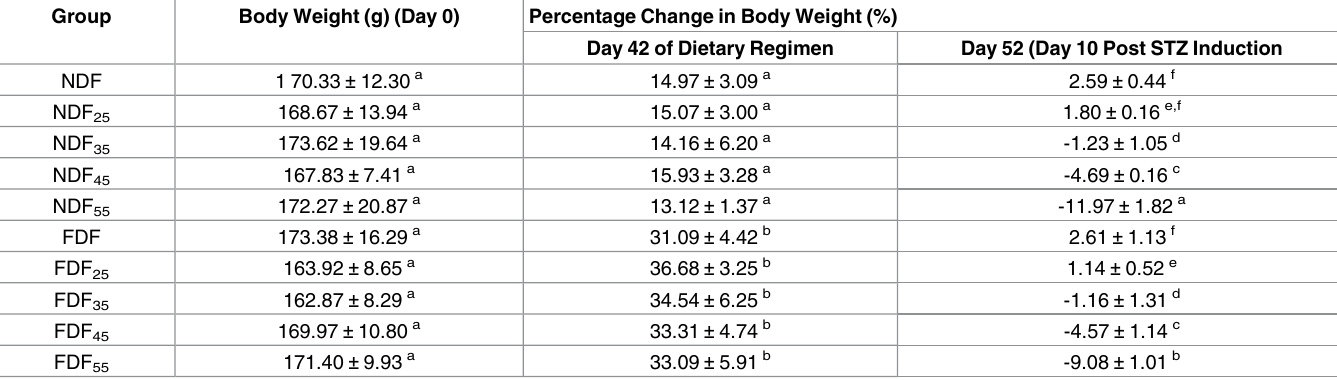
Table 1. Percentage Change in Body Weight of Rats after Dietary Regimen and STZ Induction. Group Body Weight (g) (Day 0) Percentage Change in Body Weight (%) Day 42 of Dietary Regimen Day 52 (Day 10 Post STZ Induction NDF 1 70.33 ± 12.30 a 14.97 ± 3.09 a 2.59 ± 0.44 f NDF 25 168.67 ± 13.94 a 15.07 ± 3.00 a 1.80 ± 0.16 e,f NDF 35 173.62 ± 19.64 a 14.16 ± 6.20 a -1.23 ± 1.05 d NDF 45 167.83 ± 7.41 a 15.93 ± 3.28 a -4.69 ± 0.16 c NDF 55 172.27 ± 20.87 a 13.12 ± 1.37 a -11.97 ± 1.82 a FDF 173.38 ± 16.29 a 31.09 ± 4.42 b 2.61 ± 1.13 f FDF 25 163.92 ± 8.65 a 36.68 ± 3.25 b 1.14 ± 0.52 e FDF 35 162.87 ± 8.29 a 34.54 ± 6.25 b -1.16 ± 1.31 d FDF 45 169.97 ± 10.80 a 33.31 ± 4.74 b -4.57 ± 1.14 c FDF 55 171.40 ± 9.93 a 33.09 ± 5.91 b -9.08 ± 1.01 b Data are presented as mean ± SD of 6–8 animals per group. Values with different superscript down the column indicate significant difference (P < 0.05). NDF: Group fed with Normal Diet Feed + water and treated with normal saline as control; NDF 25 : Group fed with Normal Diet Feed + Water and treated with 25mg/kg bw, STZ.; NDF 35 : Group fed with Normal Diet Feed + Water and treated with 35mg/kg bw, STZ.; NDF 45 : Group fed with Normal Diet Feed + Water and treated with 45mg/kg bw, STZ; NDF 55 : Group fed with Normal Diet Feed + Water and treated with 55mg/kg bw, STZ.; FDF: Group fed with Fortified Diet Feed + 20% fructose and treated with Normal saline; FDF 25 : Group fed with Fortified Diet Feed + 20% fructose and treated with 25mg/kg bw STZ; FDF 35 : Group fed with Fortified Diet Feed + 20% fructose and treated with 35mg/kg bw STZ; FDF 45 : Group fed with Fortified Diet Feed + 20% fructose and treated with 45mg/kg bw STZ; FDF 55 : Group fed with Fortified Diet Feed + 20% fructose and treated with 55mg/kg bw